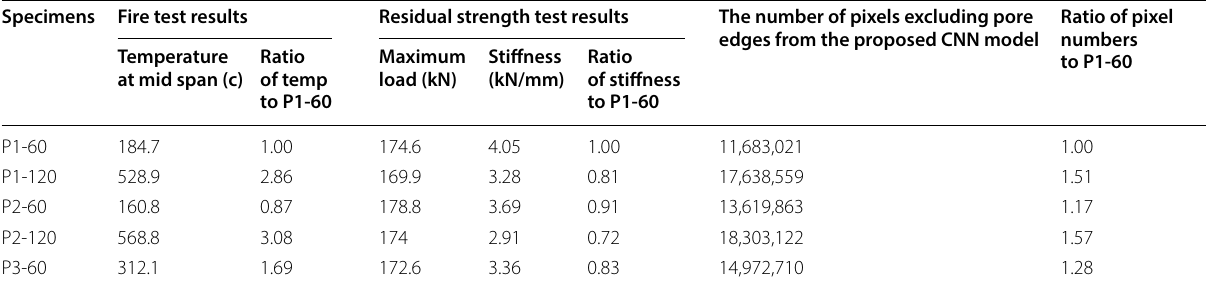
Table 7 Fire test and residual strength test results (Ryu et al. 2018) compared with number of pixels obtained from the proposed CNN